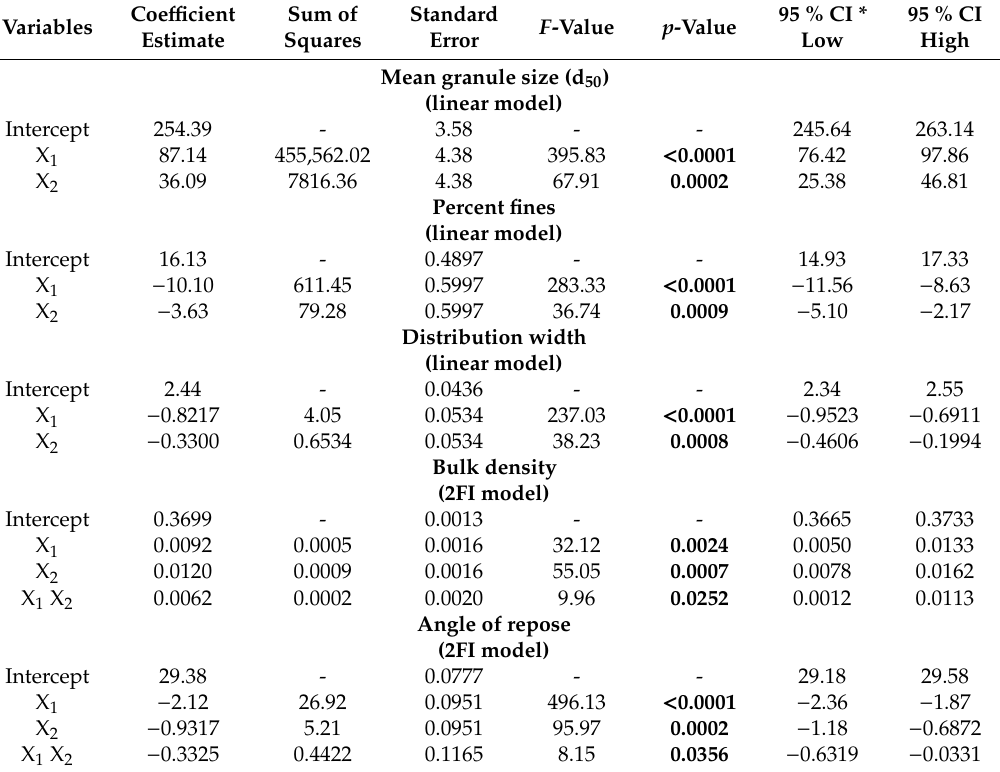
Table 3. Regression analysis of dependent responses of prepared